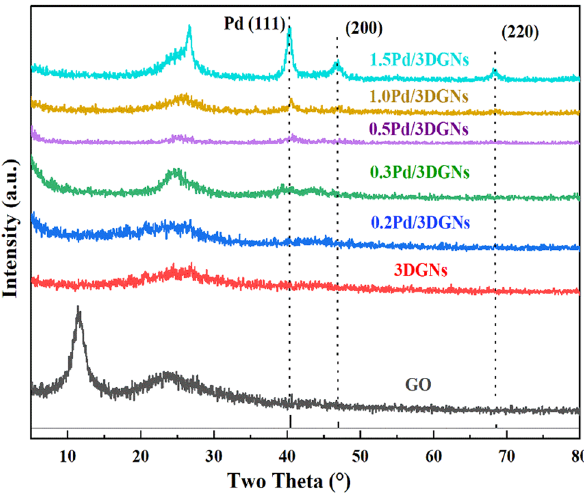
Figure 3: XRD spectra of GO, 3DGNs, and 0.2, 0.3, 0.5, 1.0, and 1.5 wt% Pd